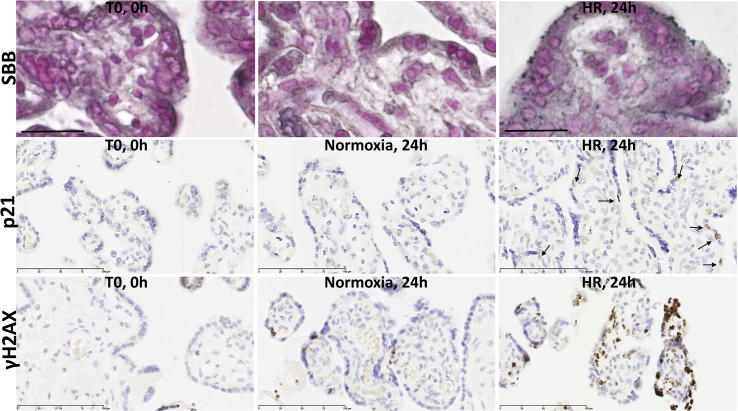
Evidence of senescence in placental explants challenged with oxidative stress of hypoxia-reoxygenation in vitro. Paraffin sections from term placental explants (N = 4), which were cultured under normoxia (N, 10% O2) or hypoxia-reoxygenation (HR, 1–10% O2) for 24 h were stained with the lipofuscin stain Sudan-Black-B (SBB; A), or immunostained with p21 (B) or modified histone, γH2AX (C), antibodies. Starting material (T0) was also stained to show the unstressed conditions at the start of the culture.